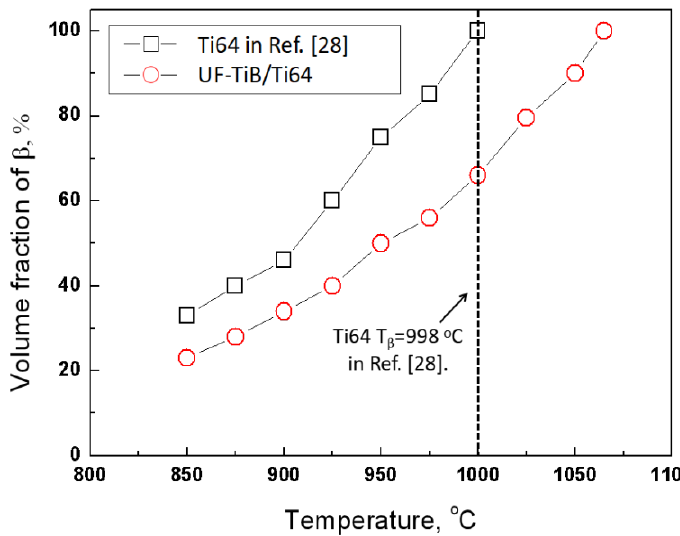
Figure 7. Temperature dependent variation of the β vol. % in both the UF-TiB/Ti-6Al-4V composite and the conventional Ti-6Al-4V alloy in Ref. [28].